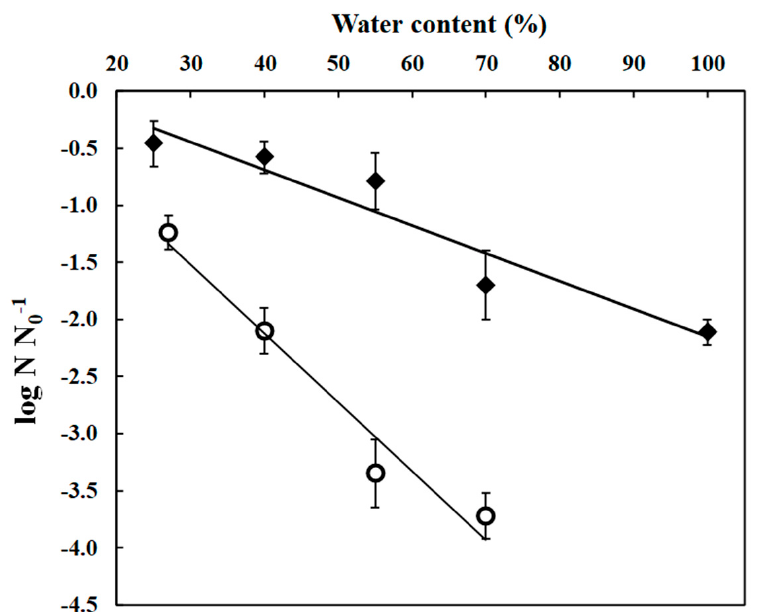
Figure 4. Effect of the initial water content on the inactivation of Clostridium spores in honey using scCO 2 ( ♦ ) and scCO 2 saturated with CEO ( ). Conditions: P = 10 MPa; T = 60 ° C; Q = 1 g min − 1 ; stirring rate = 60 rpm; operation time = 60 min. The solid line is the linear fitting.